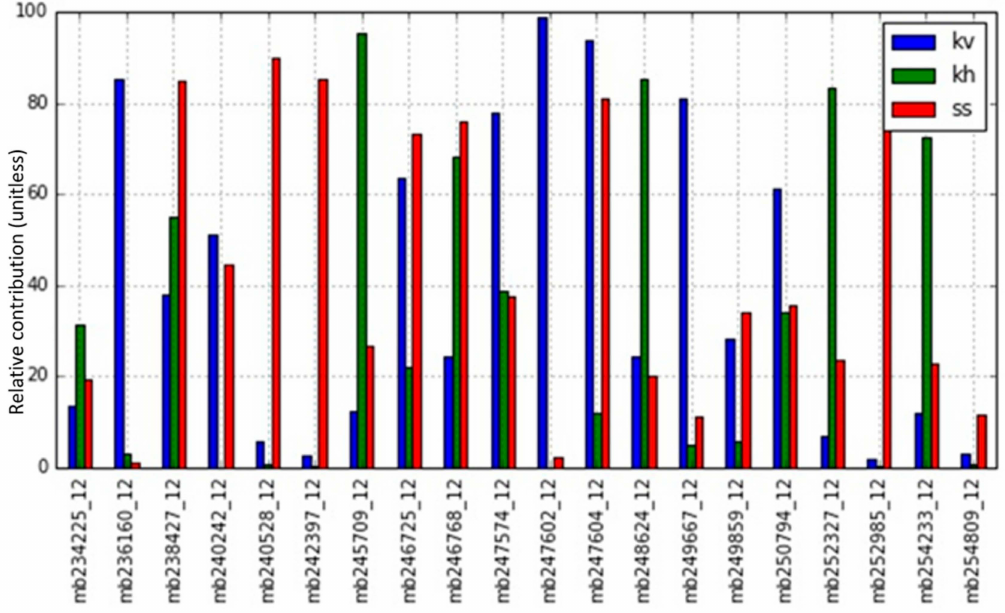
Figure 12. Relative contribution of hydraulic property parameter groups to drawdown prediction in model layer